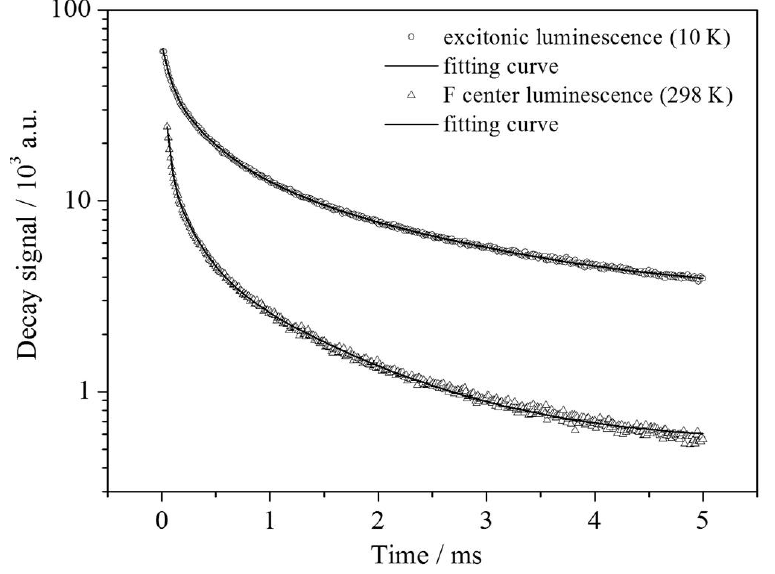
Figure 10. Semi-log plot of the luminescence decays of the observed emission bands in Ba SiO :Sr 2+ . The black curves correspond to tri-exponential fits, respectively. For the 2 4 values: see